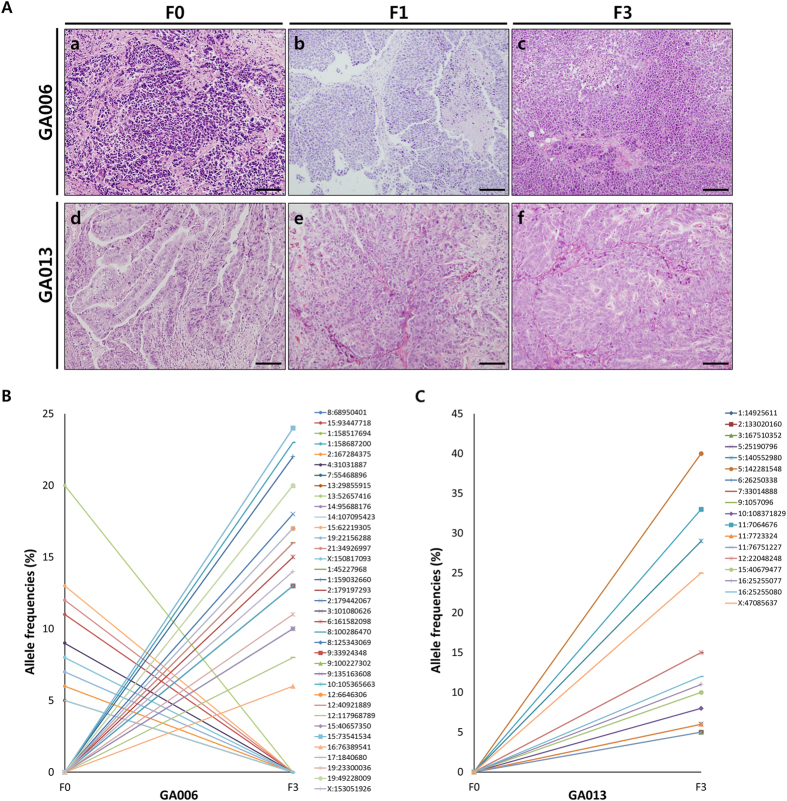
Histologic and genomic features between primary and PDX tumours.(A) Tumour section slides were stained to H & E for comparing histology of F1 and F3 PDX tumours with their corresponding F0 tumour in two PDX models. a, F0 from GA006; b, F1 from GA006; c, F3 from GA006; d, F0 from GA013; e, F1 from GA013; f, F3 from GA013. Scale bars = 100 μm. (B,C) De novo and disappeared mutations between F0 and F3 PDX tumours of GA006 (B) and GA013 (C) models. De novo mutations are defined as total allele count being zero in the F0 and greater than or equal to five in F3. The opposite cases are disappeared mutations.